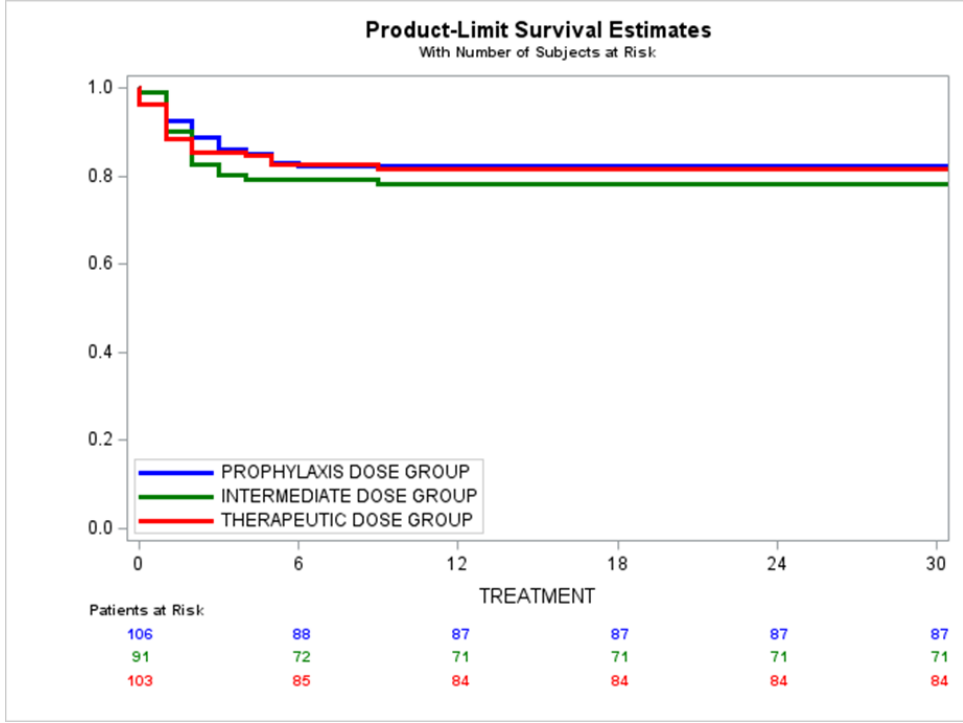
Figure 3. Overall survival of patient series, as per low molecular weight heparin group assignment at 30 days follow-up. Prophylactic dose group (tinzaparin 4500 IU/daily) Prob (95% CI): 0.82 (0.73, 0.88). Intermediate dose group (tinzaparin 100 IU/kg/day) Prob (95% CI): 0.78 (0.68, 0.85). Therapeutic dose group (tinzaparin 175 IU/kg/day) Prob (95% CI): 0.81 (0.73, 0.88). Log-rank test p -value =